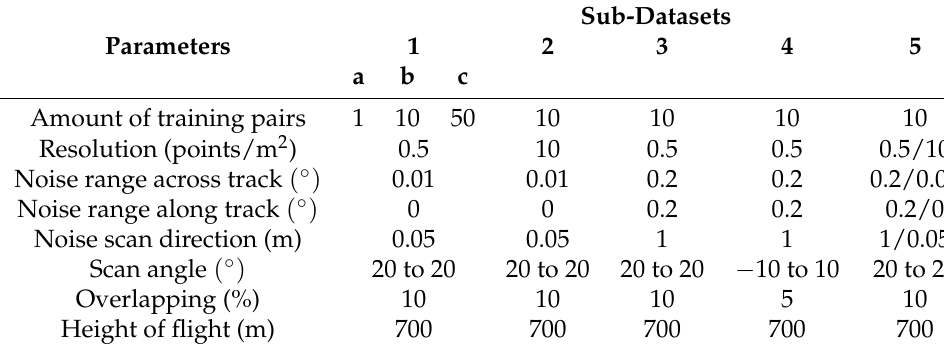
Table 1. Acquisition configurations for all sub-datasets.